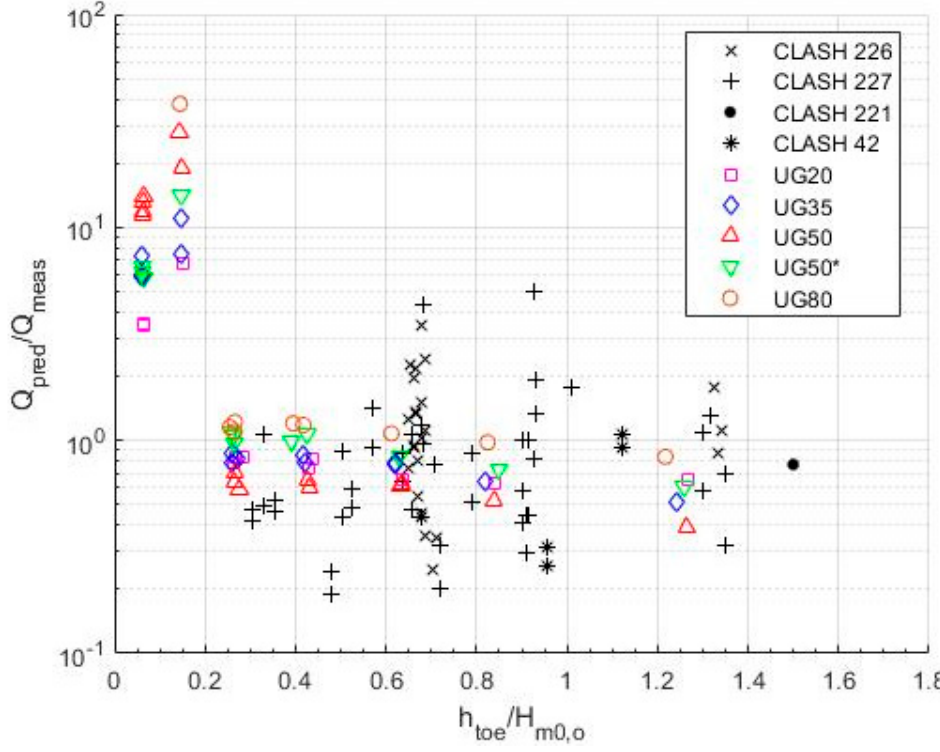
Figure 9. Ratio of dimensionless predicted by Goda [9] to measured overtopping discharge versus the relative water depth.